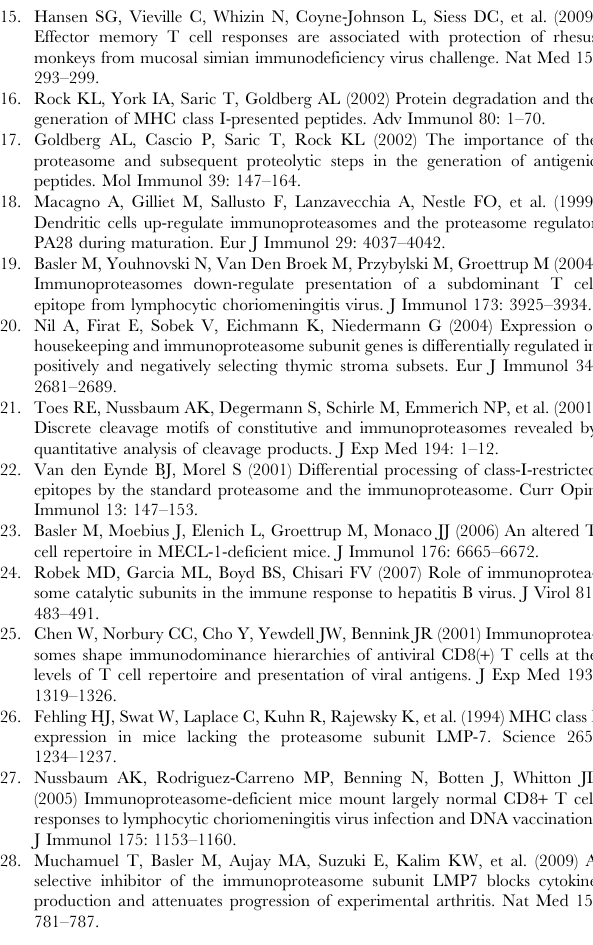
Table S1 Amino acid sequences of MCMV CD8 + T cell epitopes referred to in this study.